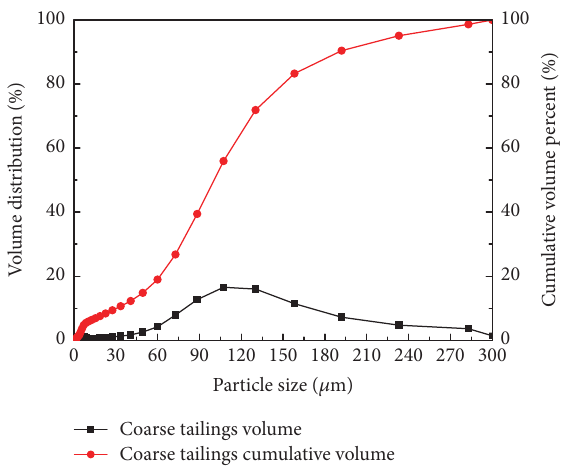
Figure 2: The tailings particle size distribution curve.